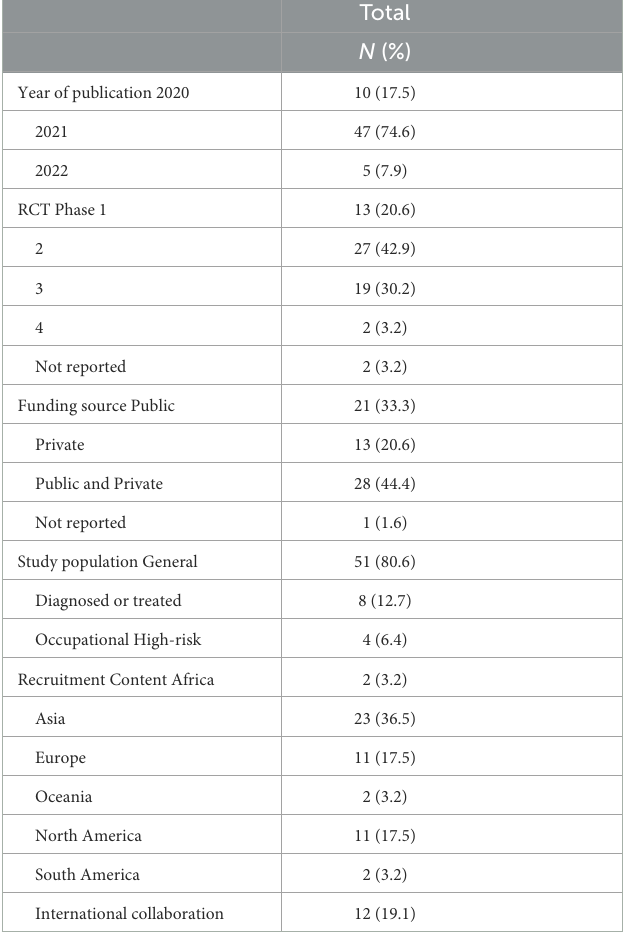
TABLE 1 Description of the characteristics of the 63 included